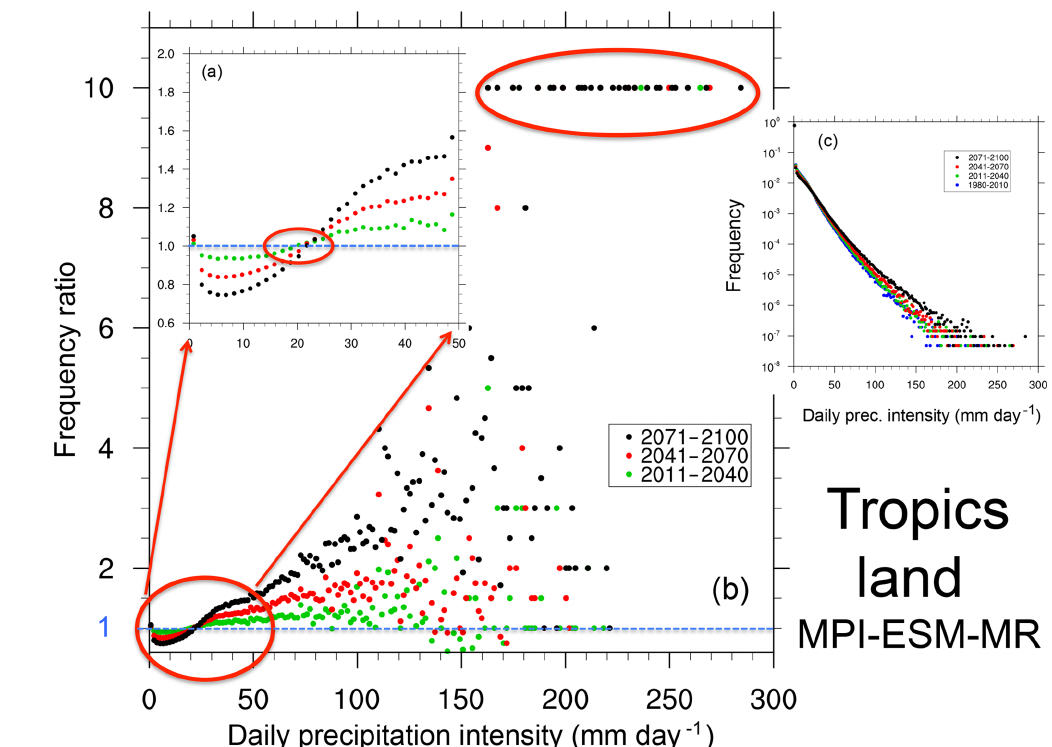
Figure 3. (a) A zoomed-in view of the part of the curves highlighted by the corresponding red oval. Ratio values of 10 (highlighted with a red oval) are used when events occur in the future time slice that are not present in the reference period for a given intensity bin. (b) Ratio of future to reference normalized frequency of daily precipitation intensity for the three future time slices. (c) Probability density function (PDF) defined as the normalized frequency of occurrence of daily precipitation events of intensity within a certain bin interval over land regions in the tropics (30 ◦ S–30 ◦ N) for the reference period 1981–2010 and three future time slices (2011–2040, 2041–2070, 2071–2100) in the MPI-ESM-MR model. The frequency is normalized by the total number of days (including dry days, i.e., days with precipitation lower than 1mmday − 1